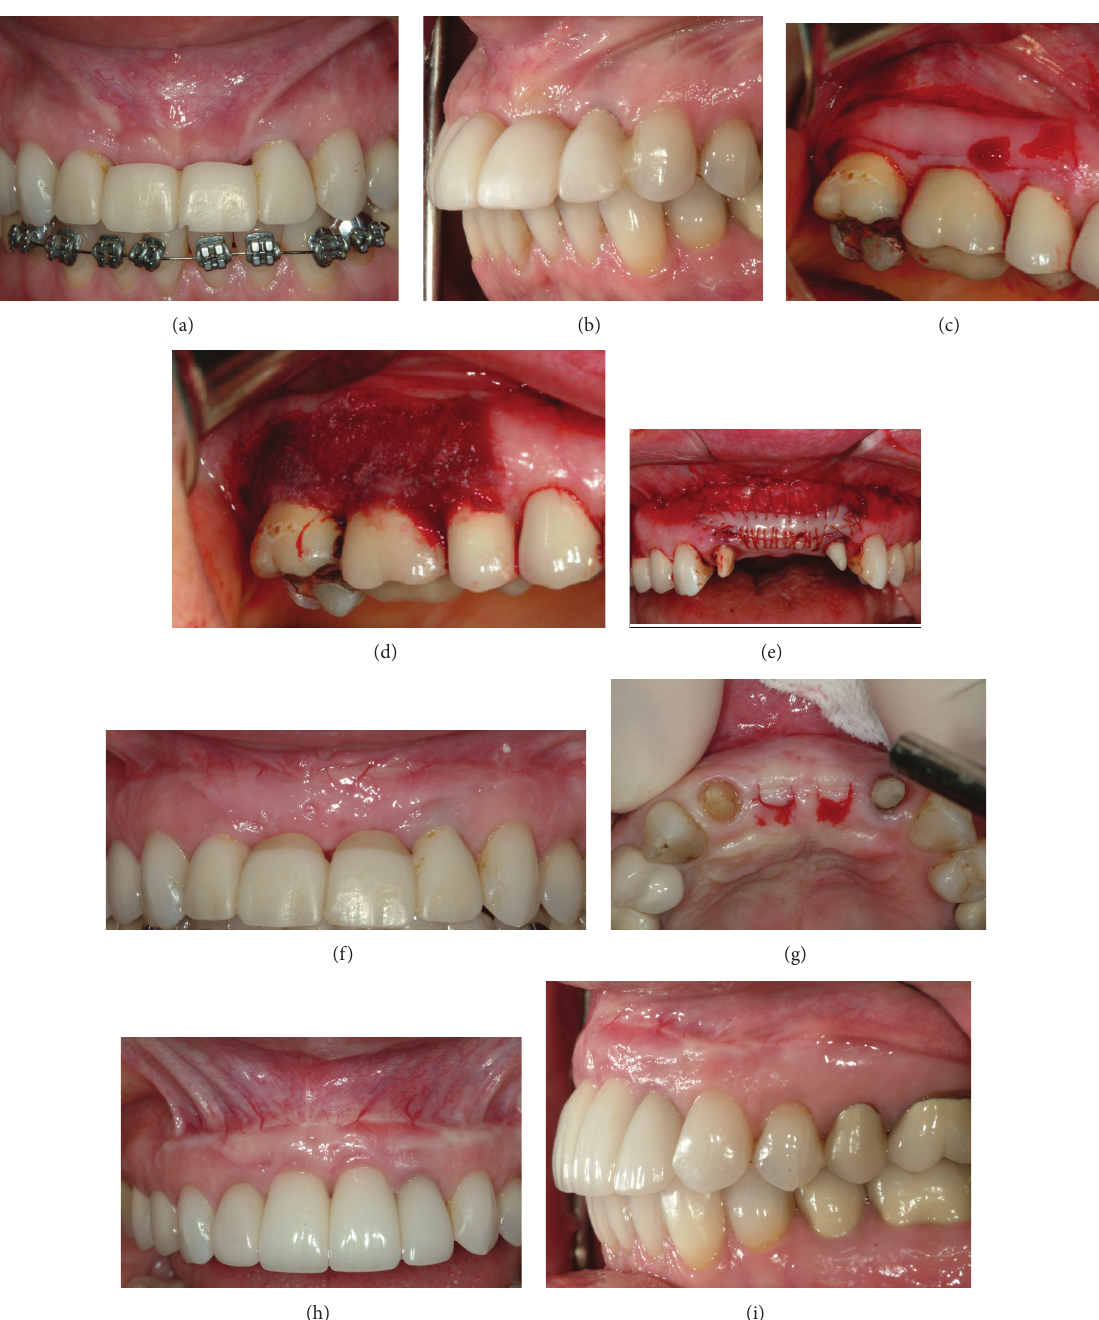
Figure 2: (a) Patient had previous bone grafting and numbers 8 and 9 implant placement. Note minimal keratinized attached gingiva over grafted area of numbers 8 and 9 due to coronal advancement of the flap. (b) Note the deficient soft tissue profile following placement of a provisional prosthesis with appropriate tooth emergence. (c) Donor site and graft procurement. (d) Collagen tape and cyanoacrylate to reduce discomfort over donor site. (e) Graft secured and well adapted to recipient bed with multiple sutures. (f) Recipient site following healing. Note the increase in height and thickness of the keratinized attached gingiva. (g) Numbers 8 and 9 implant sites prepared for second stage surgery. (h) Recipient site after numbers 8 and 9 implant restorations, showing stable keratinized attached gingiva. (i) Lateral view of recipient site. Note the thick buccal keratinized attached gingiva, establishing an esthetic emergence profile for the implant